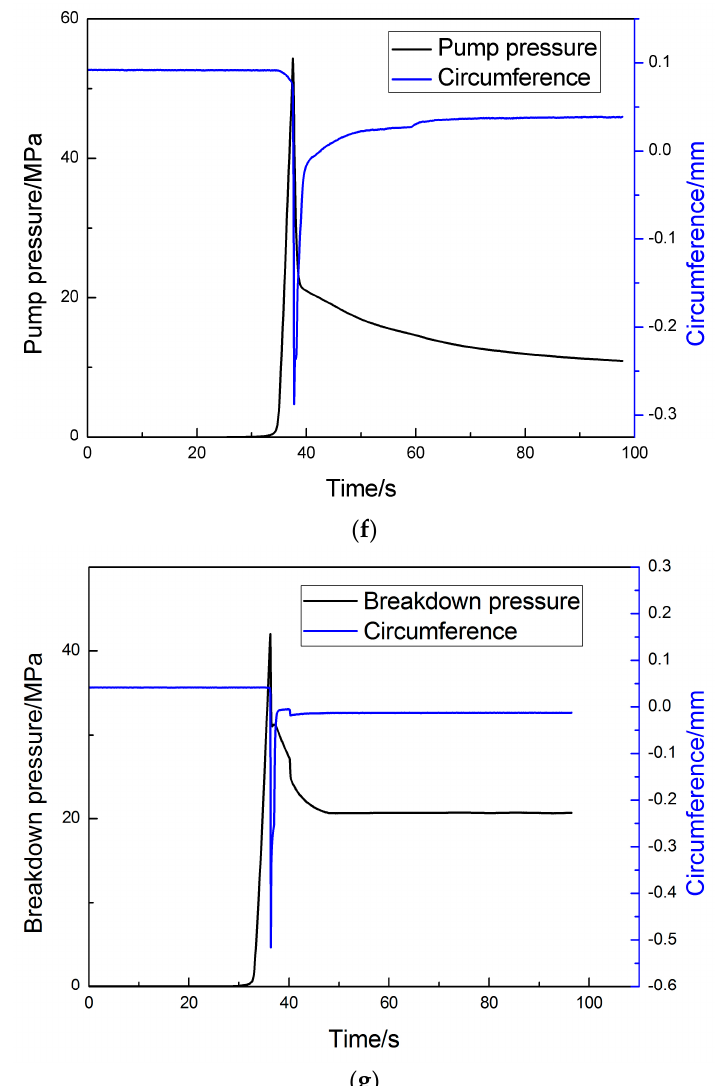
Figure 5. ( a ) Pump pressure and circumference monitoring of shale core 1 (bedding plane angle: 0°); ( b ) Pump pressure and circumference monitoring of shale core 2 (bedding plane angle: 30°); ( c ) Pump pressure and circumference monitoring of shale core 3 (bedding plane angle: 45°); ( d ) Pump pressure and circumference monitoring of shale core 4 (bedding plane angle: 60°); ( e ) Pump pressure and circumference monitoring of shale core 5 (bedding plane angle: 90°); ( f ) Pump pressure and circumference monitoring of sandstone core; ( g ) Pump pressure and circumference monitoring of granite core.